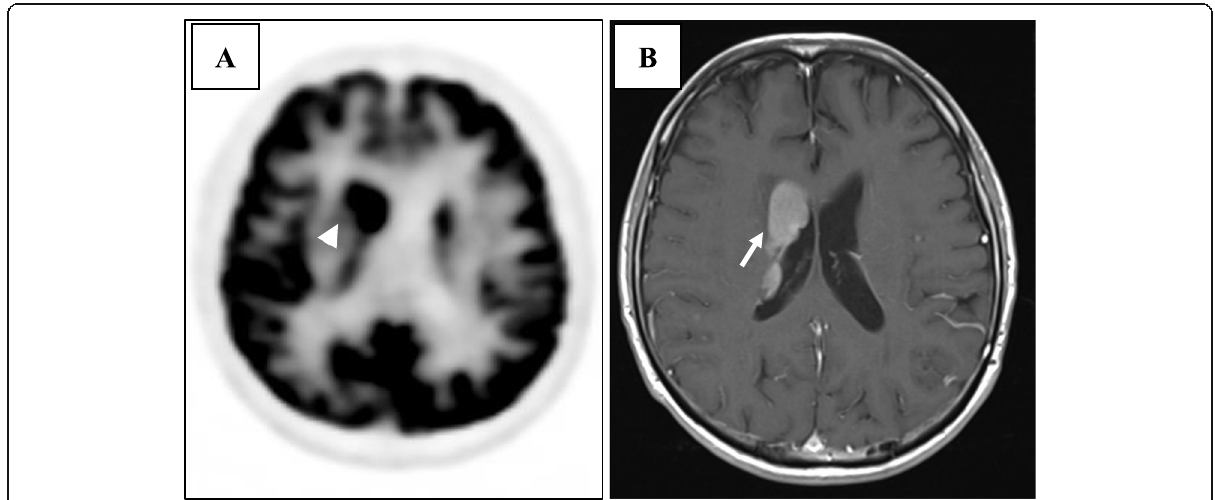
Fig. 4 Head imaging at the time of central nervous system spread. (A) PET-CT showed abnormal accumulation in the right frontal lobe (arrow head). (B) Contrast-enhanced MRI (T1) showed an enhancing effect at the same site